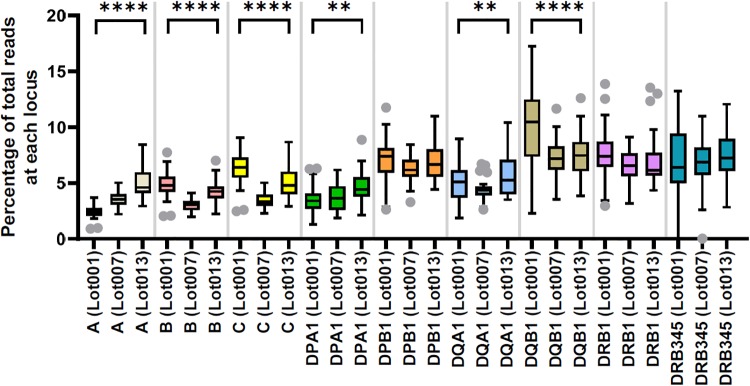
Inter-lot comparison of the percentages of total reads mapped to each locus.Each lot is represented by one run with 32 barcoded samples. Boxes represent the median and interquartile range (IQR); whiskers represent 1.5 IQR. ** P<0.01, **** P<0.0001, by ordinary one-way ANOVA.